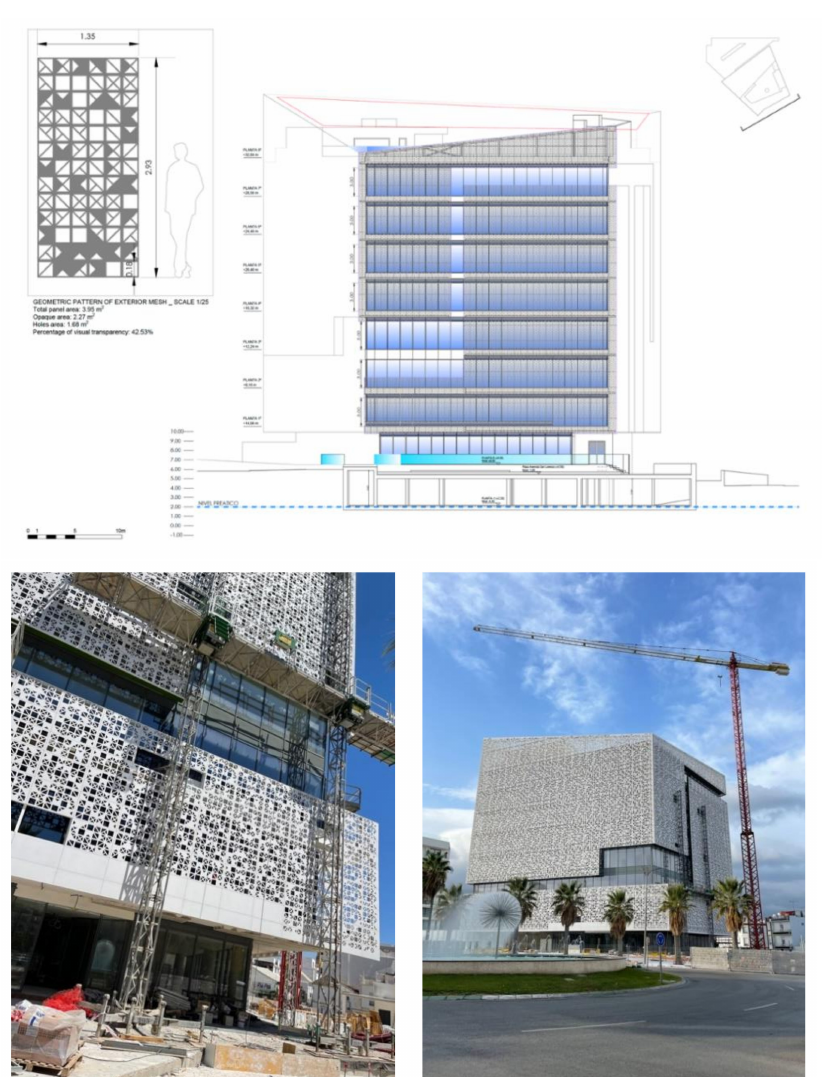
Figure 7. Double façade system with the external envelope made of lattice work. Modular geometric pattern used. South-facing elevation ( above ). Source: Castaño & Associates. LEED Rating System Report [59]. ( below ) Source: Pictures created by the